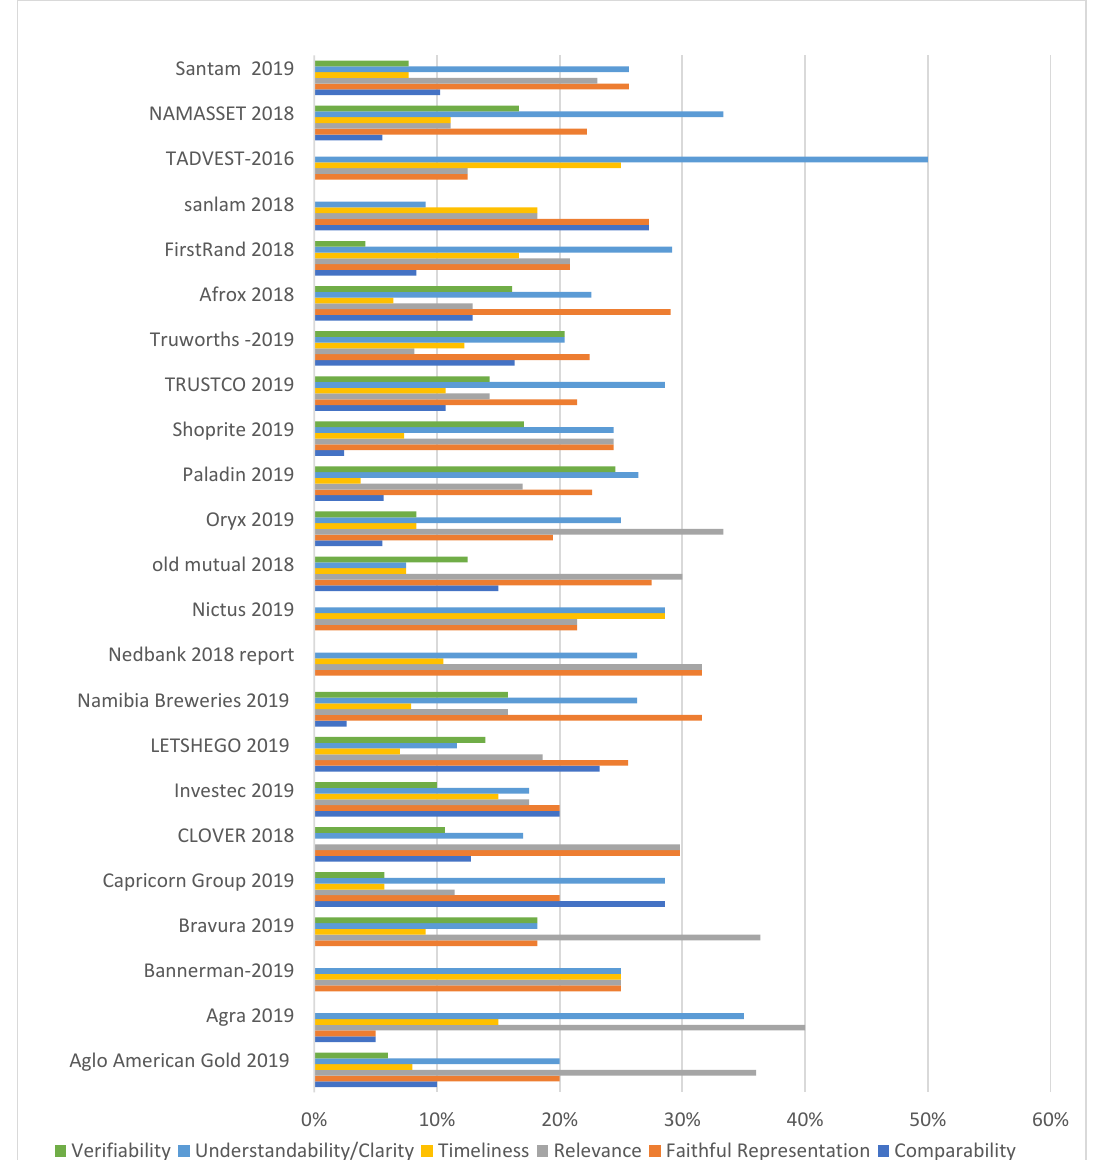
Figure 2. Decision usefulness of integrated reports by Namibian listed companies. Source: Authors’ own illustration.